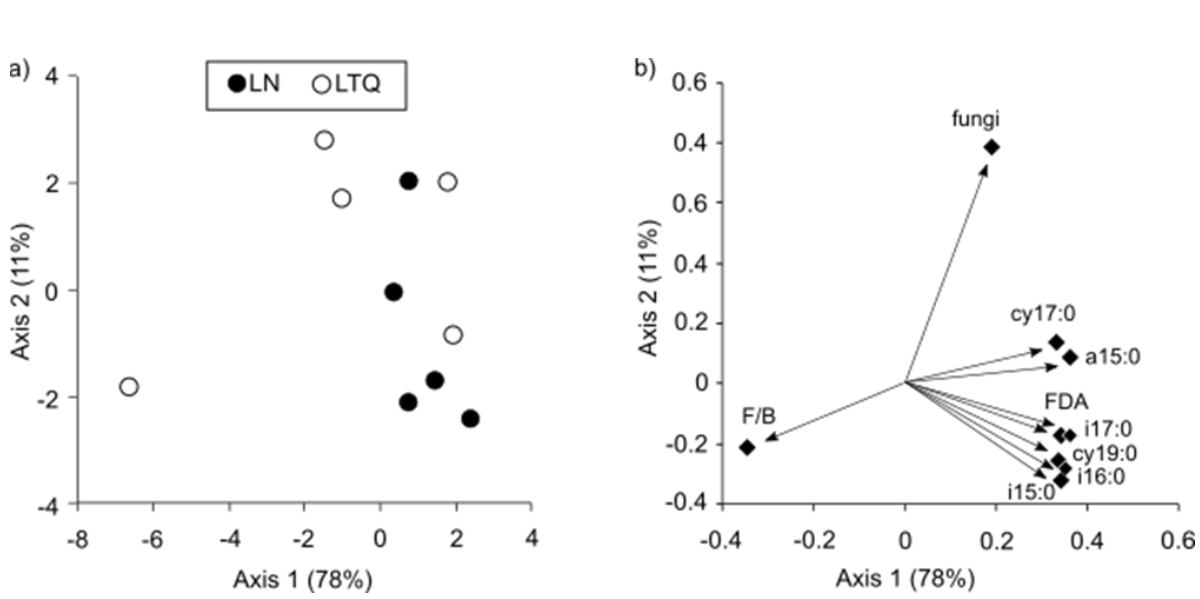
Figure 5. a) Distribution of the 10 plots in the first two axes of the principal component analysis (PCA) based on the composition and activity of active microbial communities. b) Ordination of bacterial and fungal phospholipid fatty acid (PLFA) markers (as indicators of microbial biomass and community composition), fungi/bacteria quotient (F/B), and fluorescein di-acetate (FDA) hydrolysis rate (as indicator of microbial activity). LN: peatland associated with Laguna Negra, LTQ: peatland associated with Laguna Tres Quebradas. The percent variability explained by each axis of the PCA is shown (between